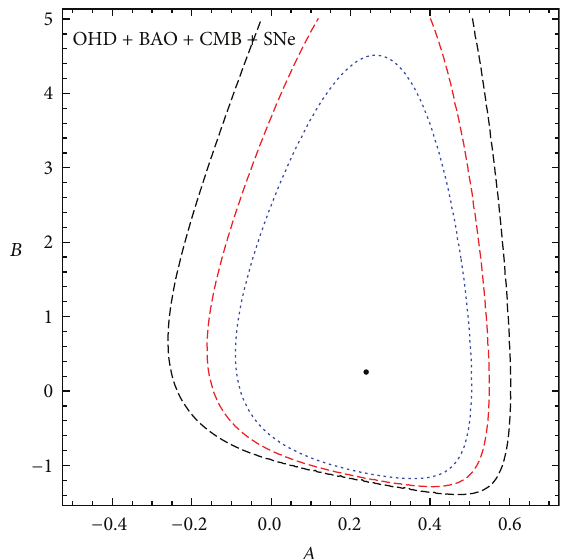
Figure 4: It shows the variations of 𝐴 with 𝐵 for 𝛼 = 0.1 for OHD + BAO + CMB and OHD + BAO + CMB + SNe analysis, respectively, for different confidence levels say 66% (solid, blue), 90% (dashed, red), and 99% (dashed, black) contours.